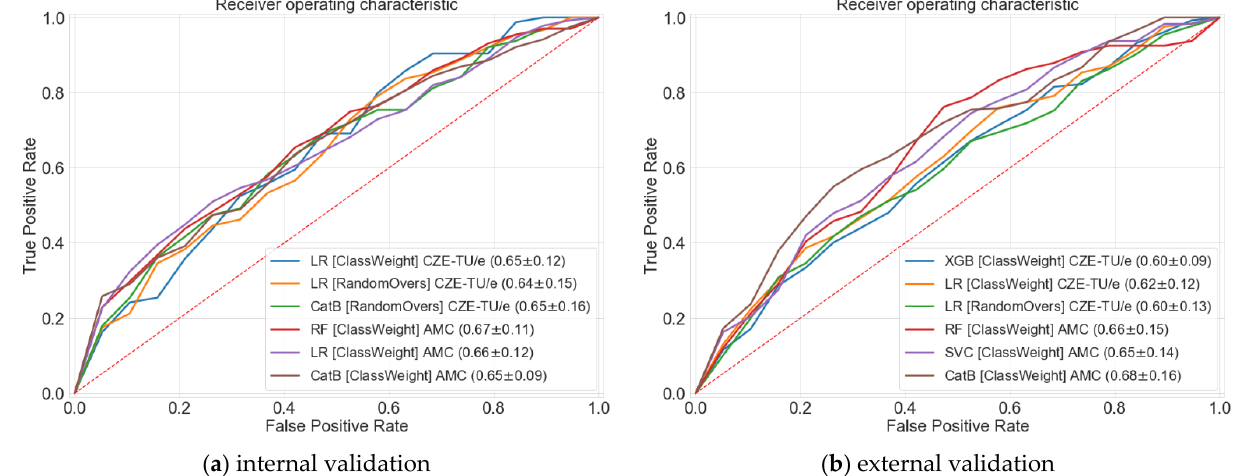
Figure 5. Area under curve (AUC) of the receiver operating characteristic (ROC) for the top-three classifiers per center with the highest validation score are shown with different colors. Both centers internal validation ( a ) and external validation ( b ) AUC metrics are shown jointly in this figure to highlight the similarity.